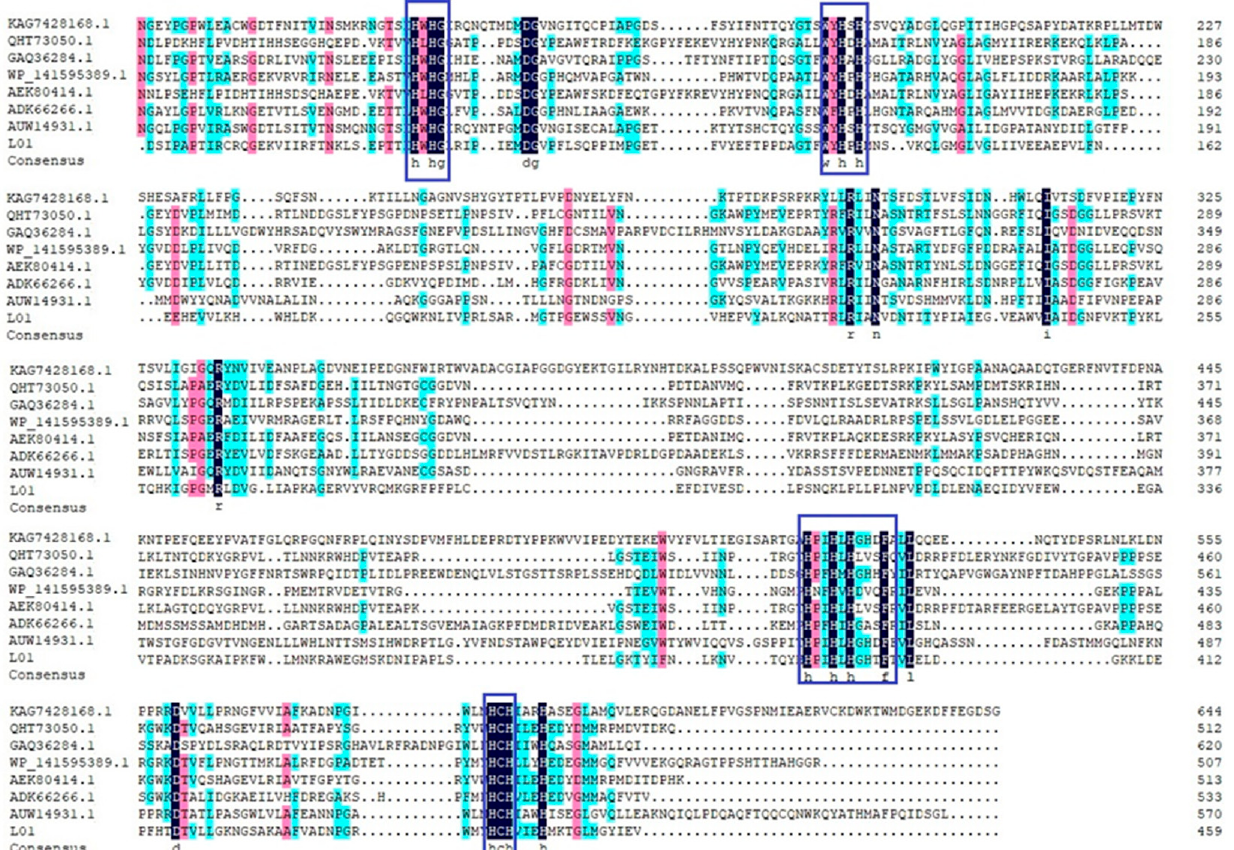
Figure 2. Multiple sequence alignments of L01 with other well-characterized bacterial and fungal laccases, with conserved motifs marked in blue boxes.